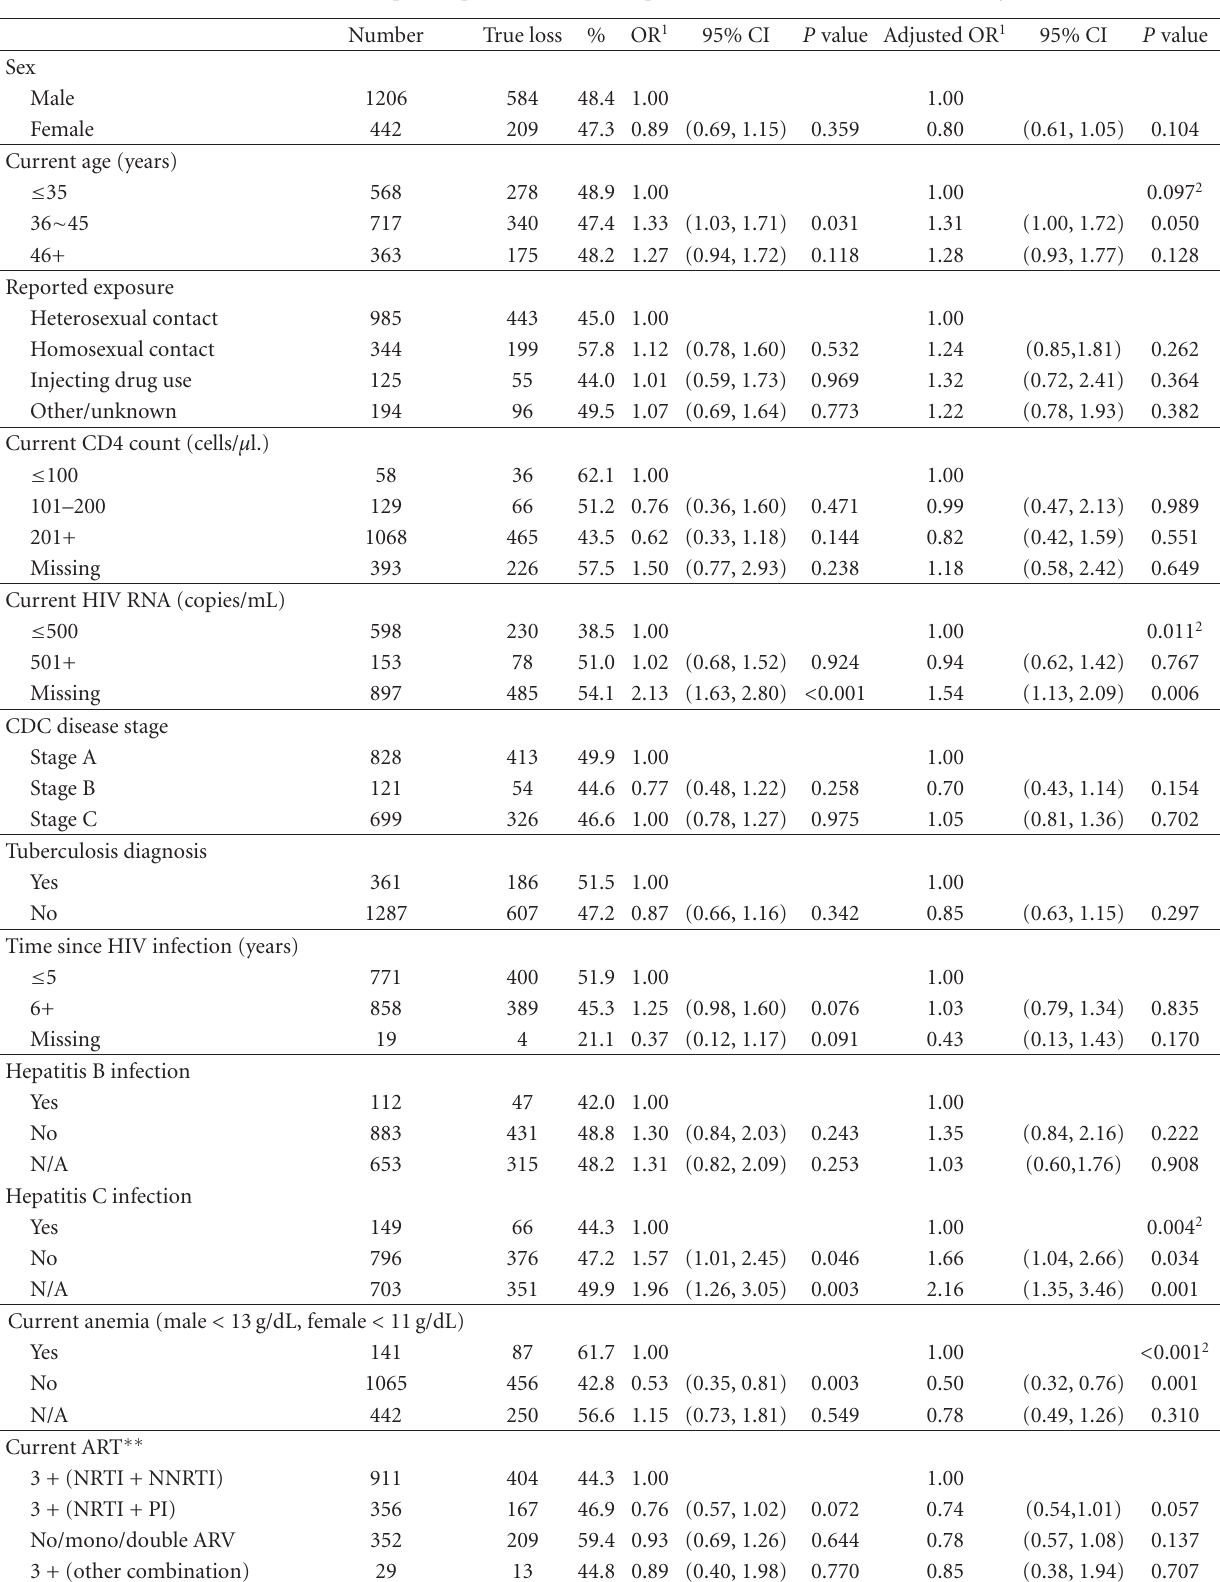
Table 4: Factors that predict permanent LTFU in patients without a clinic visit for 180